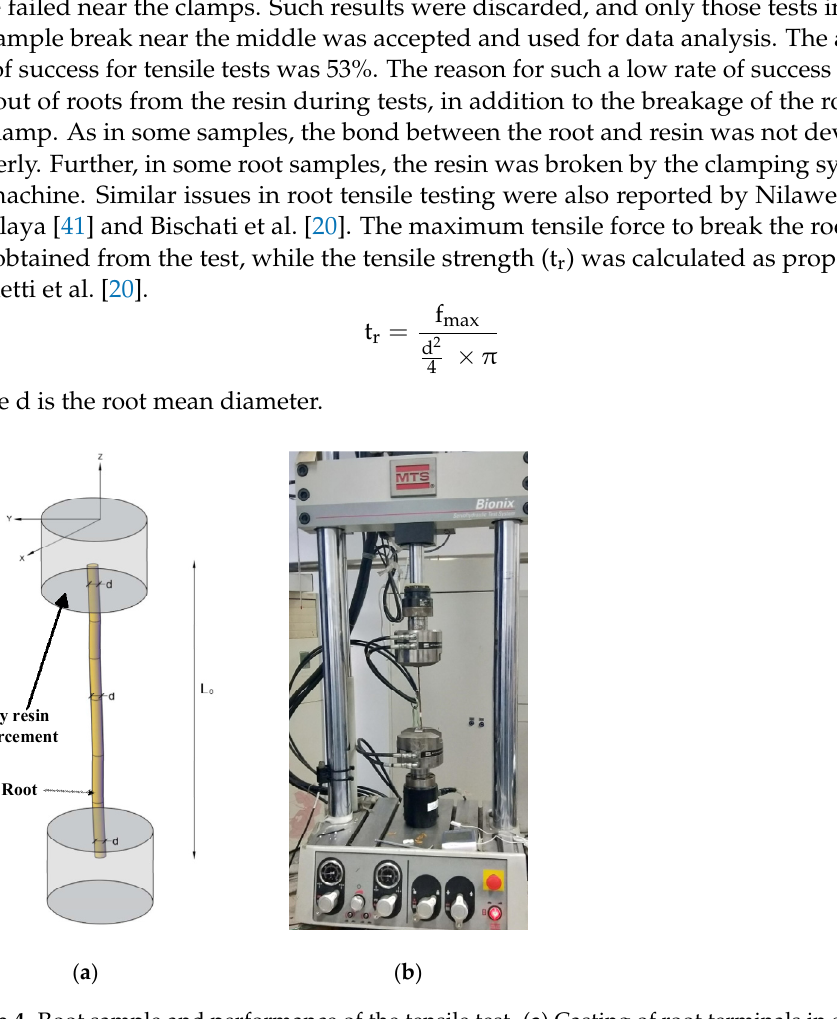
Figure 4. Root sample and performance of the tensile test. ( a ) Casting of root terminals in synthetic resins. The tensile force of the root was measured in z-direction, d = root diameter measurement, L 0 is the root initial length ( b ) MTS Bionix ® Servohydraulic Test System used for performing the tensile test.